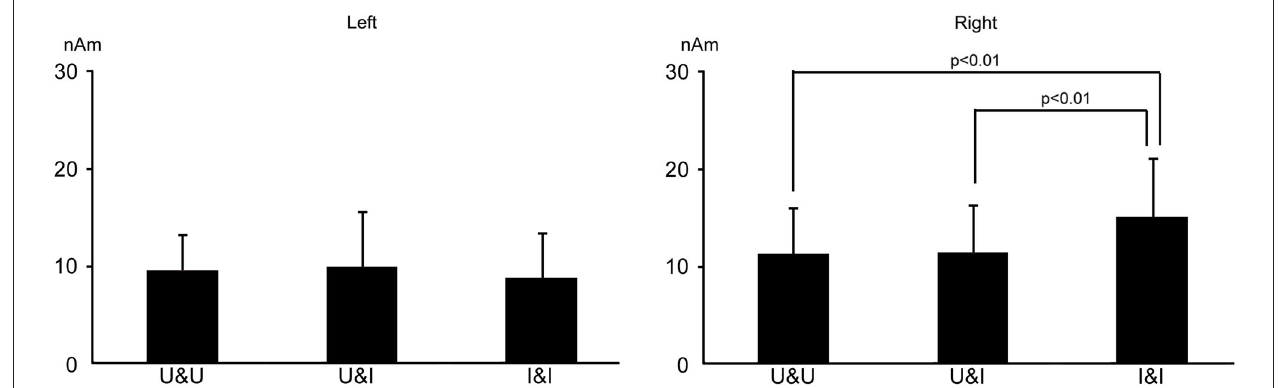
respectively. The maximum of the dipole moment was larger for I&I than for U&U and U&I in the right hemisphere ( p < 0.01), but not the left ( Figure 7